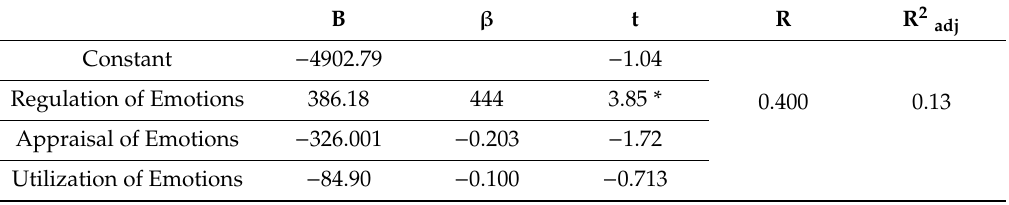
Table 3. The ability of the trait emotional intelligence to predict HF power during recovery. B β t R R 2